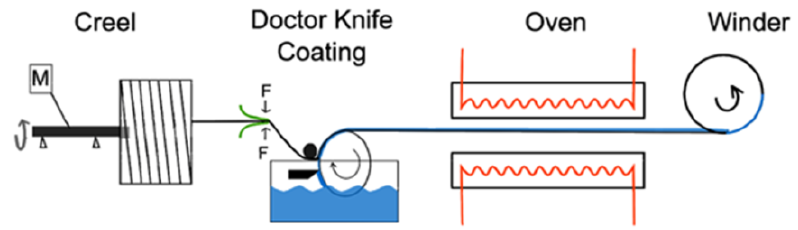
Figure 2. Schematic process of a secondary fiber coating device, consisting four individual devices [14].